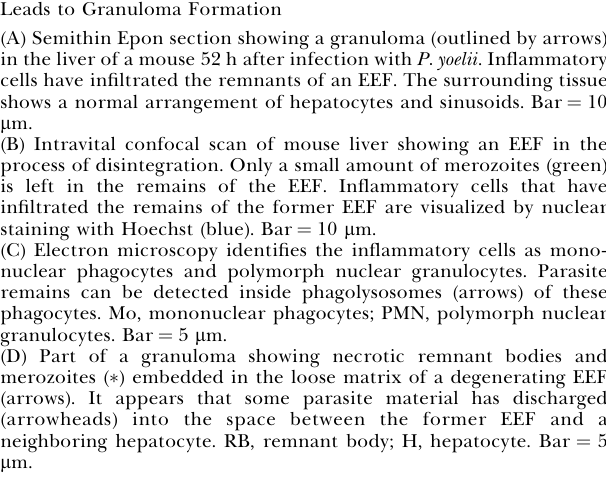
Figure S1. Infiltration of Disintegrating EEFs by Inflammatory Cells Leads to Granuloma